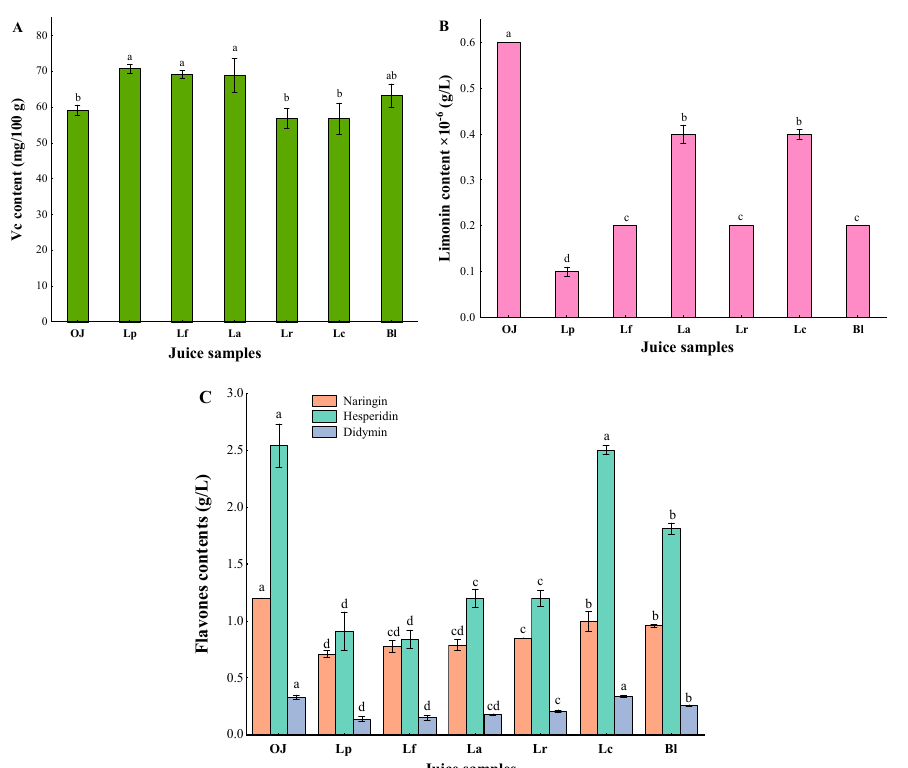
Figure 3. Vc ( A ), limonin ( B ) and flavones contents ( C ) of the orange juices fermented by Lactiplanti- bacillus plantarum (Lp), L . fermentum (Lf), L . acidophilus (La), L . rhamnosus (Lr), L . paracasei (Lc), Bifidobacterium longum (Bl) and control ( n = 3). Control (OJ) was original orange juice. a–d Different letters in the same column indicate significant differences ( p < 0.05).